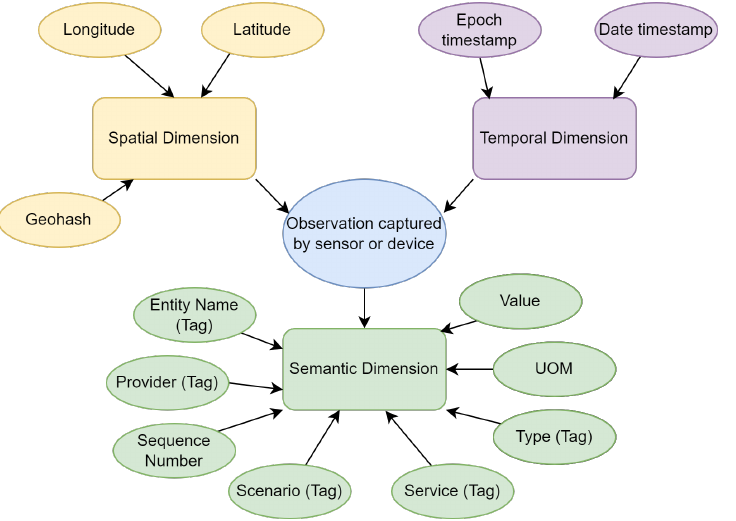
Figure 1. Data model of Observations.